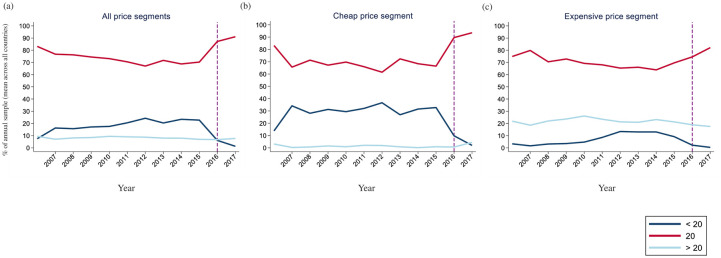
Pack size category as a percentage of the annual sample over time (a) pack size composition across all price quartiles (b) pack size composition of the cheap quartile (c) pack size composition of the expensive quartile.The dashed reference bar indicates the year of introduction of the TPD.